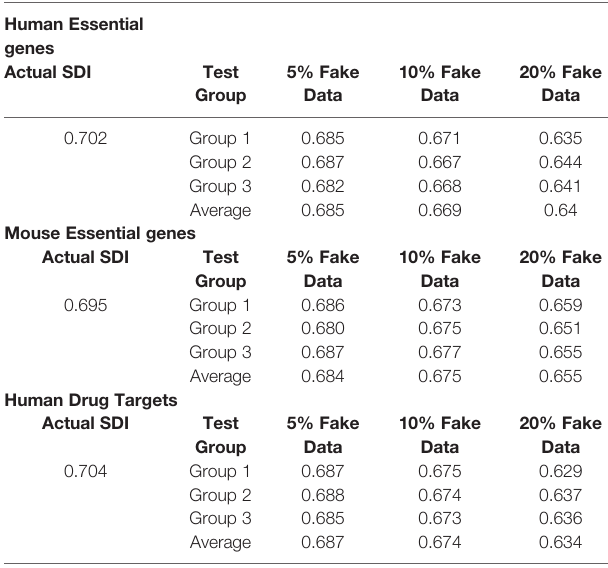
TABLE 3 | Sensitivity analyses show the robustness of the SDI